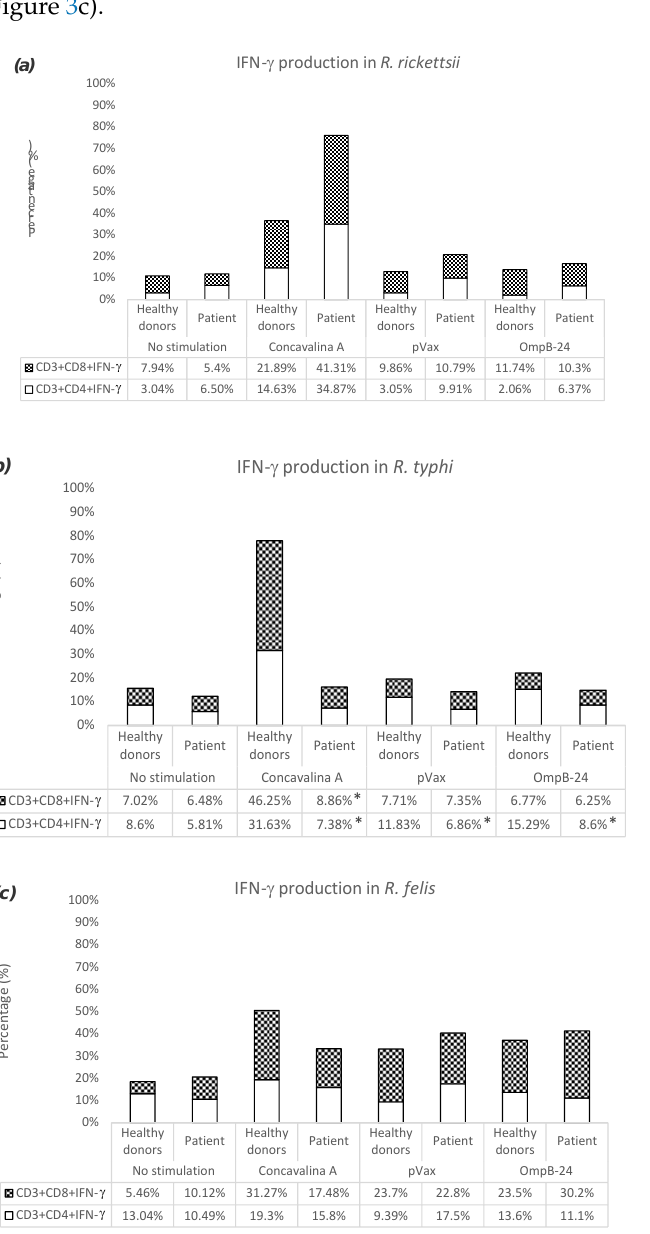
Healthy donors Patient